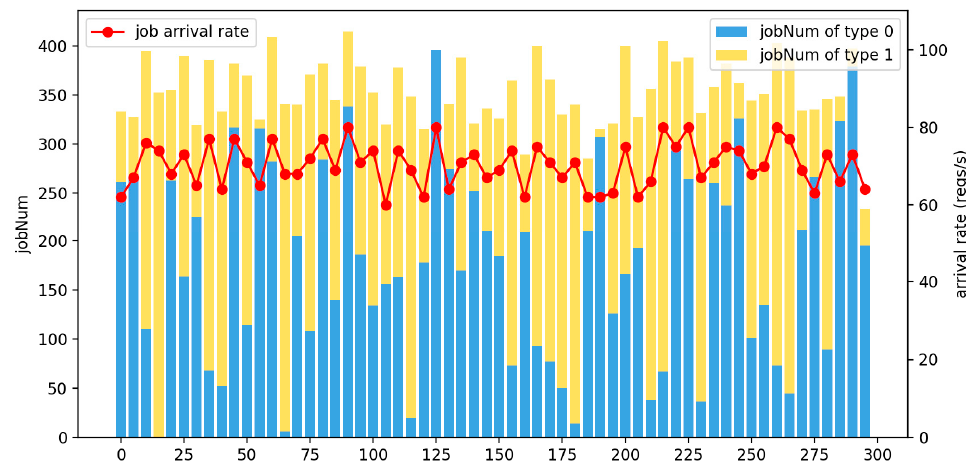
Figure 11. Job arrival rate in high-frequency workload mode.